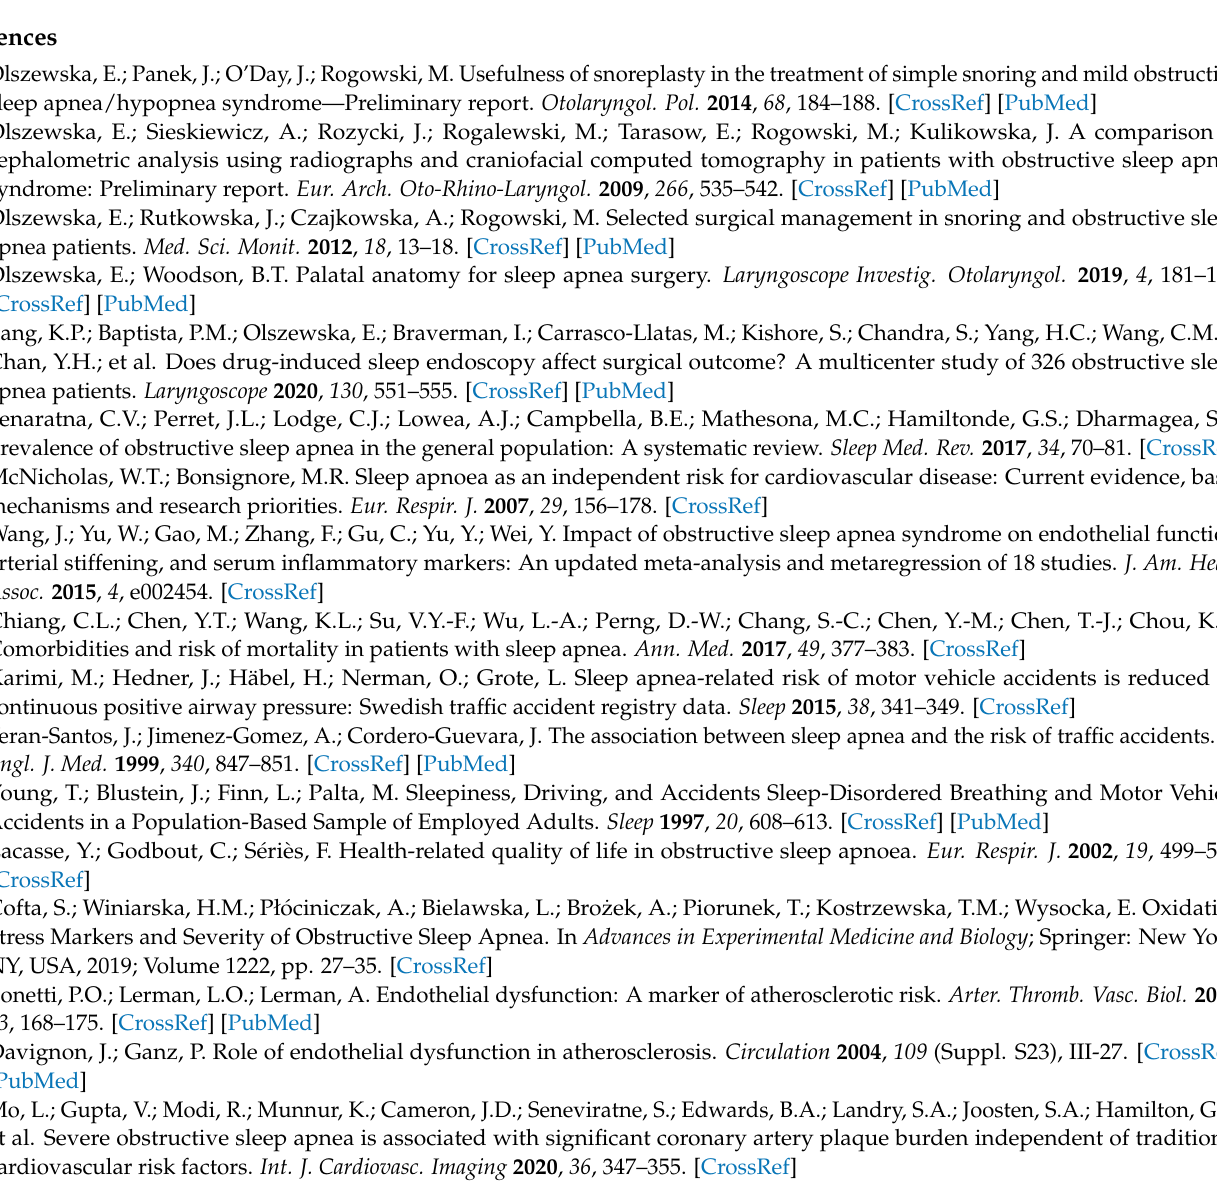
Table S2: Summary of meta-analyses included with quality